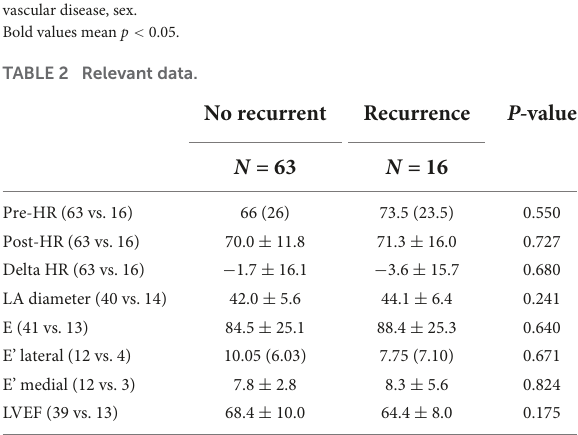
TABLE 2 Relevant data.